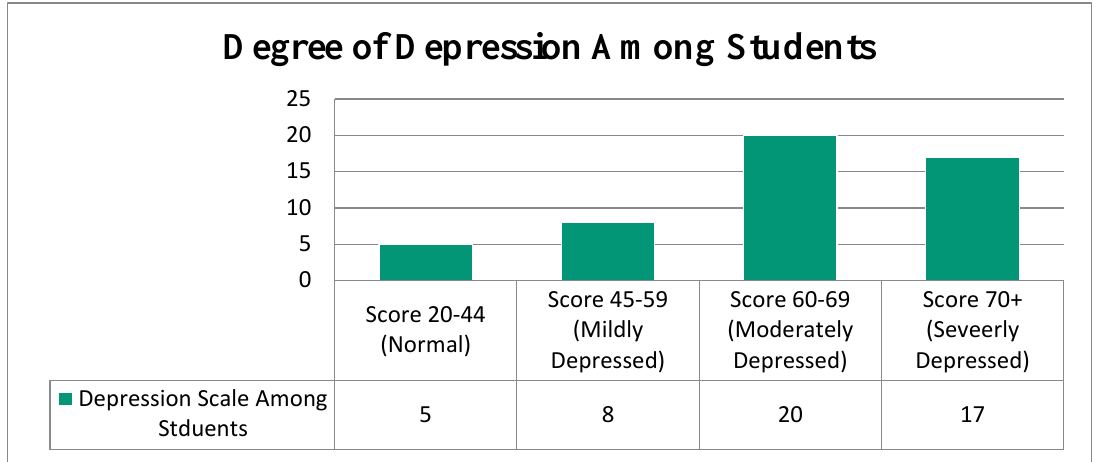
Figure 1 : Figure 1 shows that among the 50 respondents, 5 respondents shows normal symptoms hence scoring below 44 in Zung Depression scale, while 8 students shows symptoms of mild depression, the degree of depression reach on the highest scale by 20 students who experience moderate depressions, and 17 students scored 70+ thus being severely depressed. 38 among 50 students who are suffering types of depressions, says they are losing interest to study.